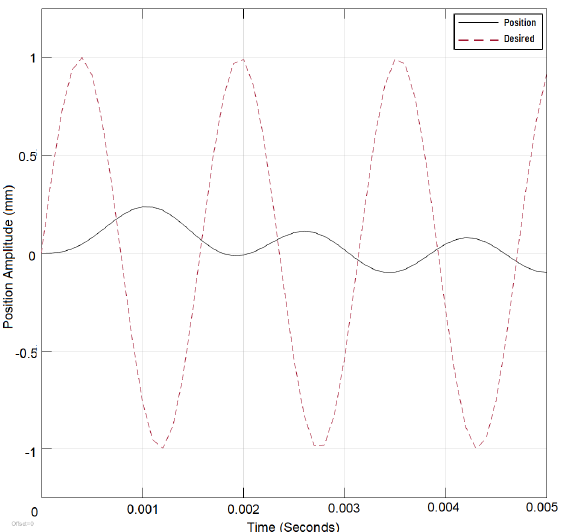
Figure 9. PID controlled position with reference to sinusoidal wave. The figure shows a 10 Millisec- onds snippet of 4000 rad/s